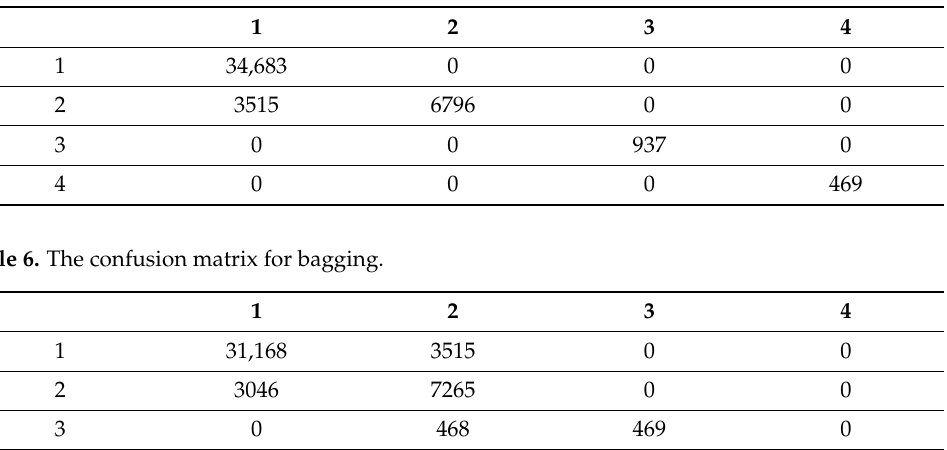
Table 5. The confusion matrix for gradient boosting.